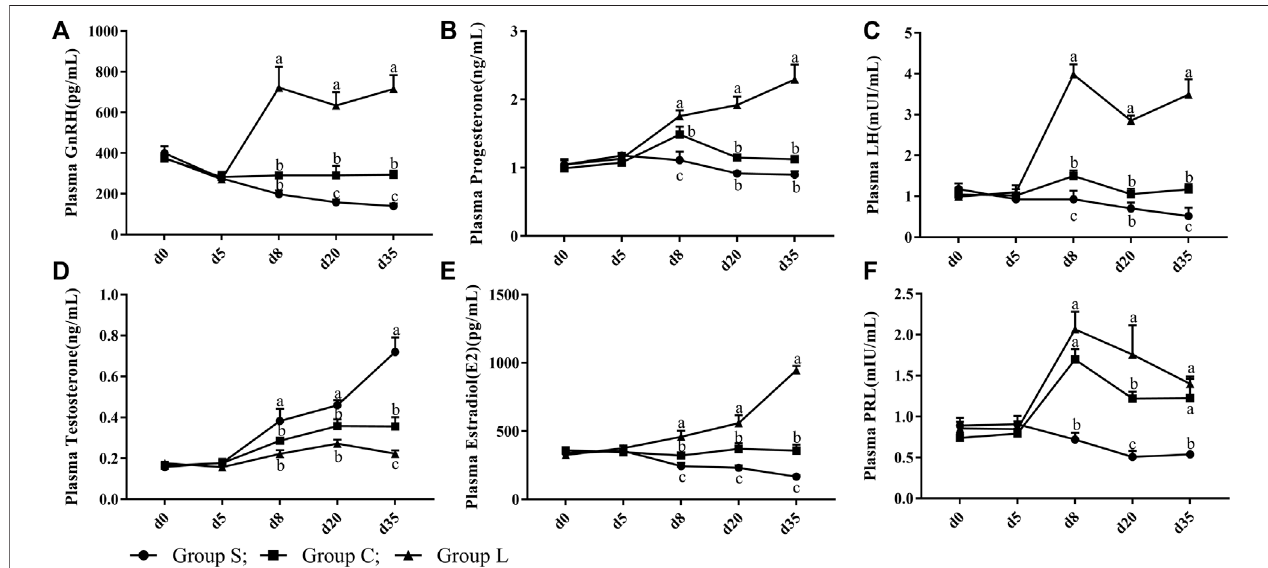
FIGURE 3 | Serum reproductive hormone levels of mountain ducks under different photoperiods. (A – F) indicated the levels of GnRH, Progesterone, LH, Testosterone, Estradiol, PRL reproductive hormones, respectively.